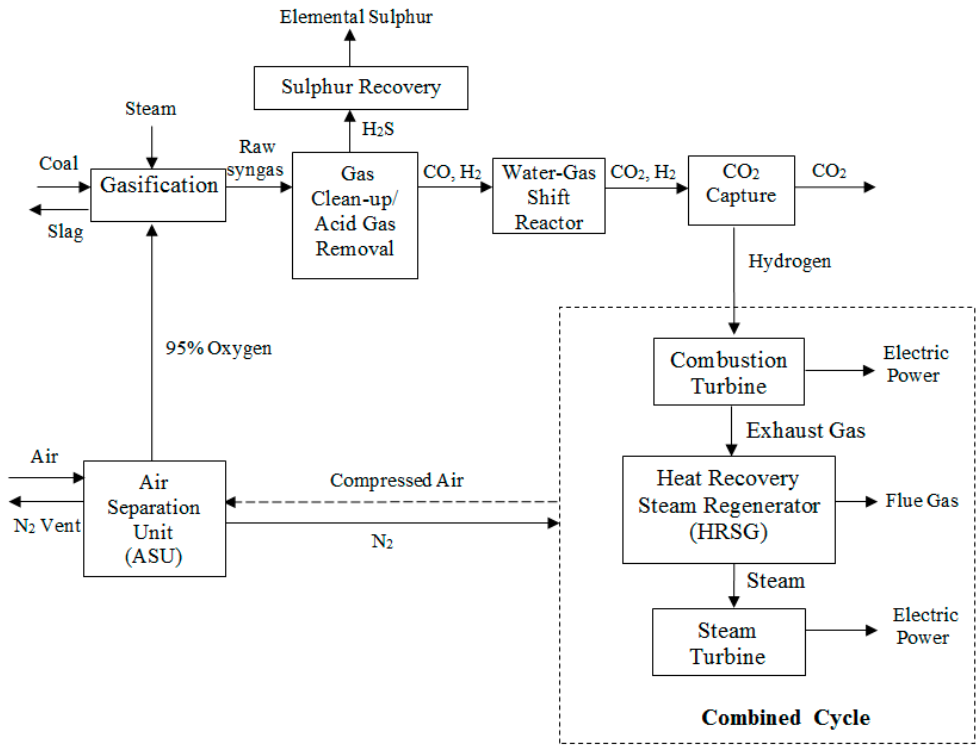
Figure 4. Simplified flow diagram of IGCC with CO 2 capture process.